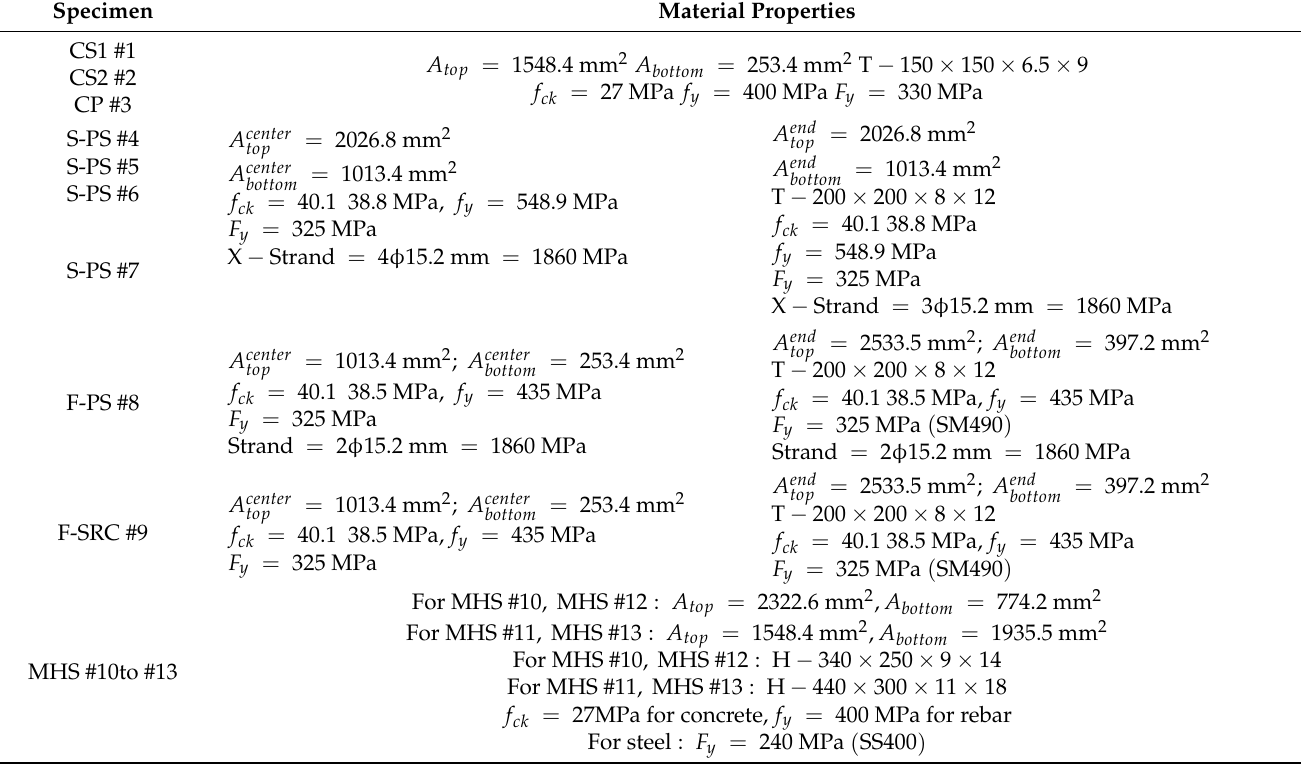
Figure 1. Specimen details. ( a ) Cantilever Specimens #1, #2, and #3 (non-pre-stressed, CS1, CS2, and CP) [24]. ( b-1 ) Specimens #4, #5 (pre-stressed); cross-sections of the test specimens with pinned joints [21,22]. ( b-2 ) Specimens #6, #7 (pre-stressed); side views of the test specimens with pinned joints [21,22]. ( c-1 ) Specimen #8 (pre-stressed); end and mid-section of a pre-stressed composite beam with fixed ends [7]. ( c-2 ) Specimen #9 (non-pre-stressed); end and mid-section of a non-pre-stressed composite beam with fixed ends [7]. ( d ) Specimens #10 to #13; Steel-concrete composite beams with fixed ends (yield strength of concrete: 27 MPa, yield strength of rebar: 400 MPa; yield strength of steel: 240 MPa) [5]. Table 2. Material properties of specimens for estimation of post-yield deflection [5,7,21–26]. Specimen Material